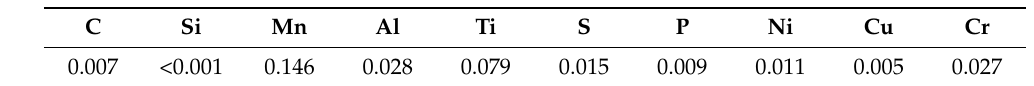
Table 4. ULC composition/wt.%.